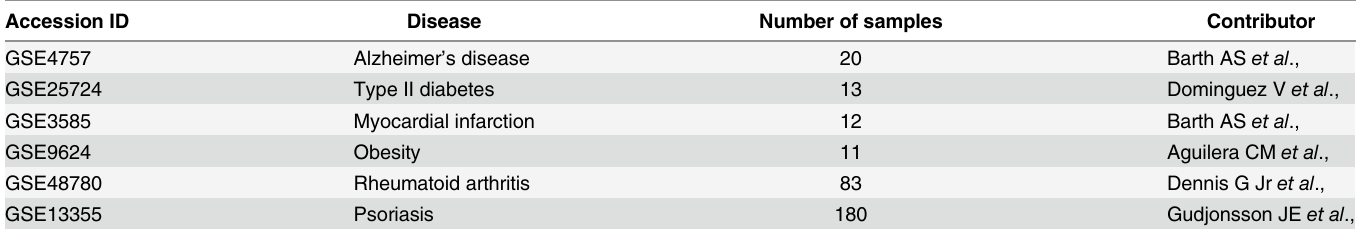
Table 1. Gene expression datasets used for the